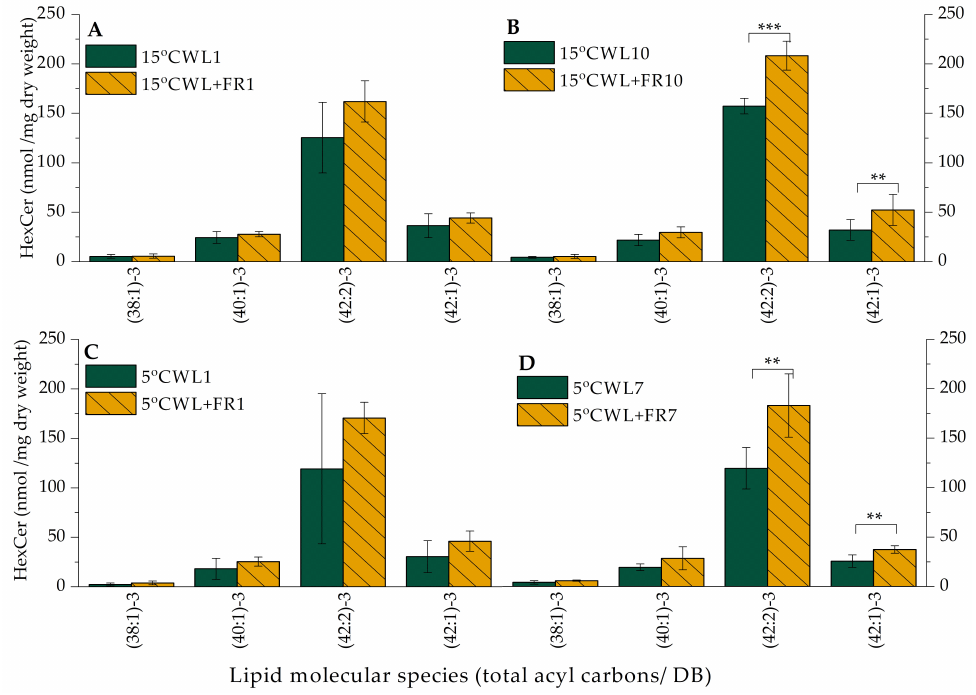
Figure 6. HexCer lipid-class distribution of barley “Nure” leaves grown at 15 ◦ C for 1 day ( A ) and for 10 days ( B ), as well as in leaves grown at 5 ◦ C for 1 day ( C ) and for 7 days ( D ), under WL and WL + FR. Mean values ± SD were calculated from 3 independent biological replicates. Significance levels are designated as ** p < 0.05, *** p <